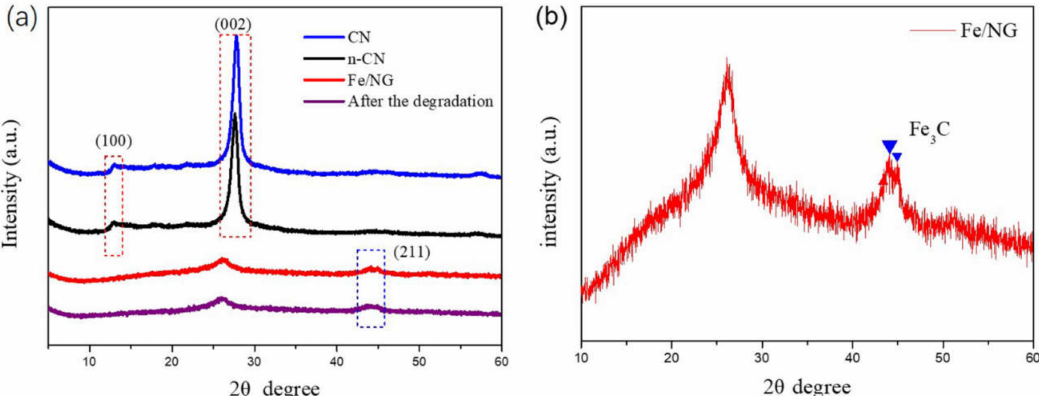
Figure 2. ( a ) XRD pattern of CN, n-CN and Fe/NG; ( b ) enlarged view of XRD pattern of Fe/NG.